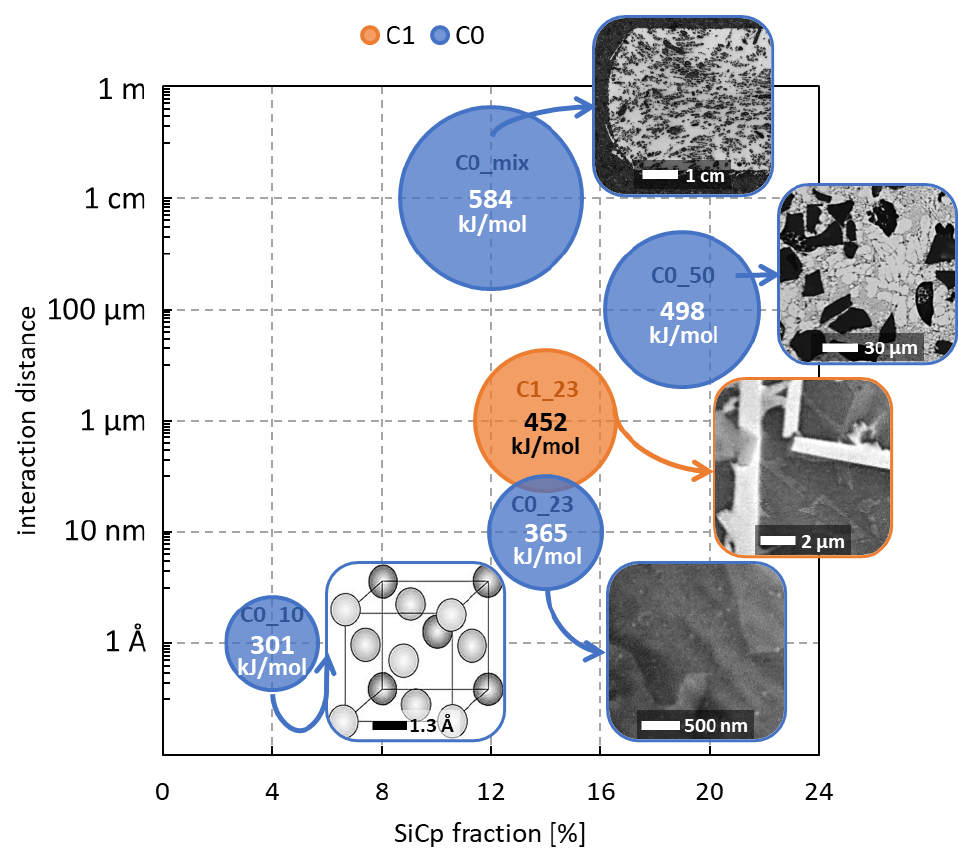
Figure 6. Relation between the activation energy Q A , the SiCp fraction and the interaction distance. The size of the bubble is proportional to the Q A value.